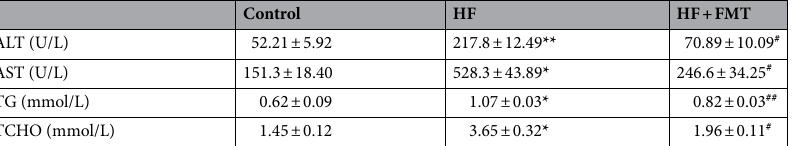
Table 1. Effects of fecal microbiota transplantation (FMT) on plasma biochemistry. Results are expressed as means ± SEM. * p < 0.05 vs. Control; ** p < 0.01 vs. Control; # p < 0.05 vs. HF; ## p < 0.01 vs.